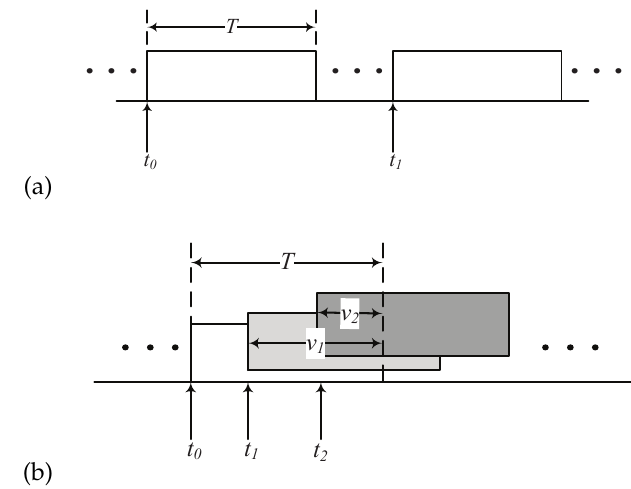
Figure 2. Scenarios of transmitted packets: ( a ) no overlapped packets during a period of collision for a tagged packet, ( b ) a tagged packet undergoes collisions by other